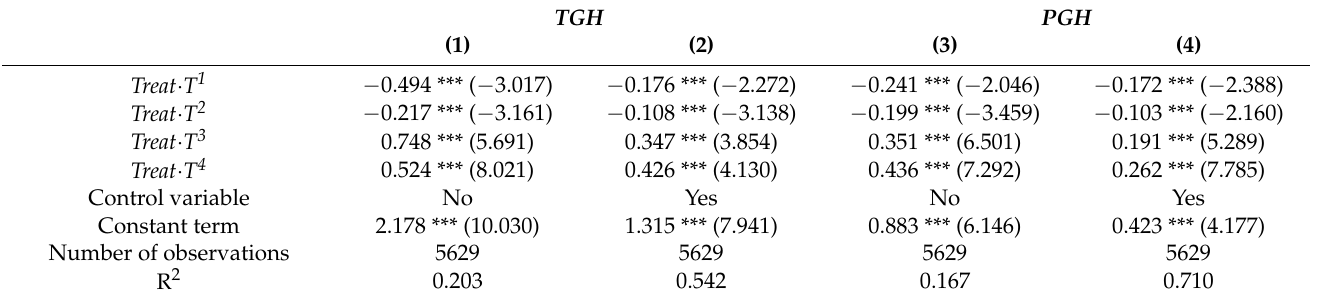
Table 6. Test results of the dynamic effects of households’ part-time farming on grain output. TGH